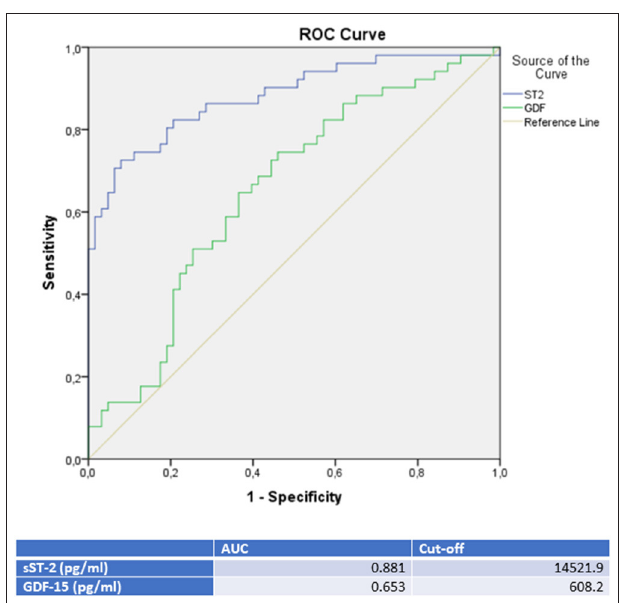
FIGURE 3 | ROC-Curves and cut off scores for sST-2 (ST2) and GDF-15 (GDF) prediction of TTC in the total cohort (including patients with TTC and